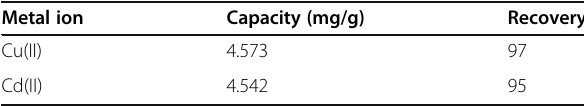
Table 5 Capacity for the metal ions and recovery